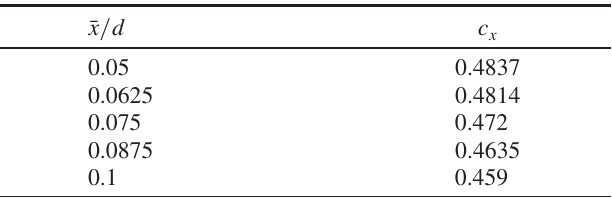
II. c x values as a function of ¯ x=d